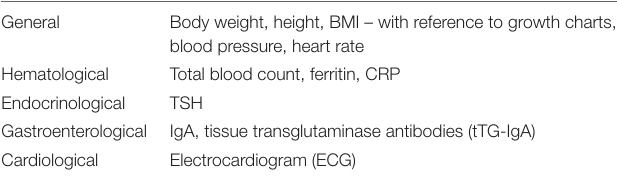
TABLE 3 | Recommended diagnostics in patients with suspected ED in primary pediatric care. General Body weight, height, BMI – with reference to growth charts, blood pressure, heart rate Hematological Total blood count, ferritin, CRP